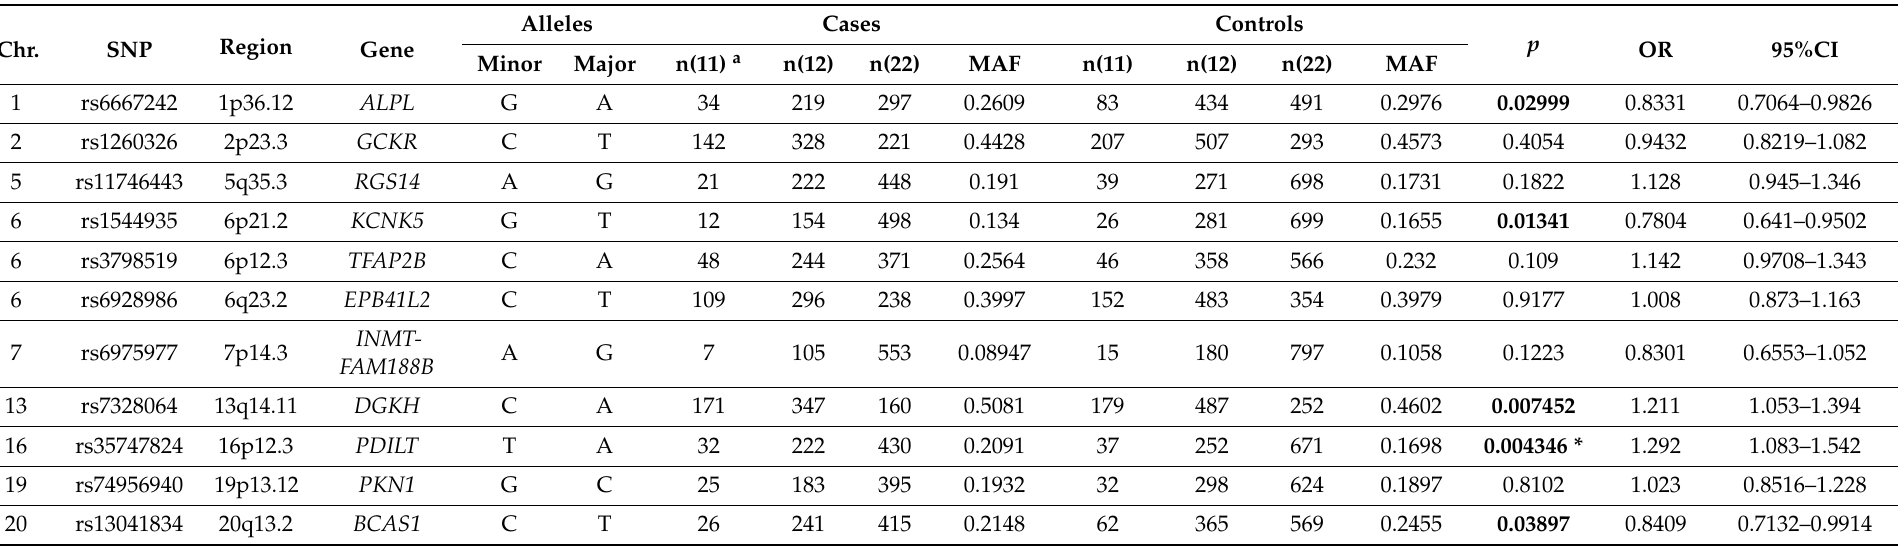
Table 2. Results of the association analysis for calcium nephrolithiasis in the Chinese Han population.